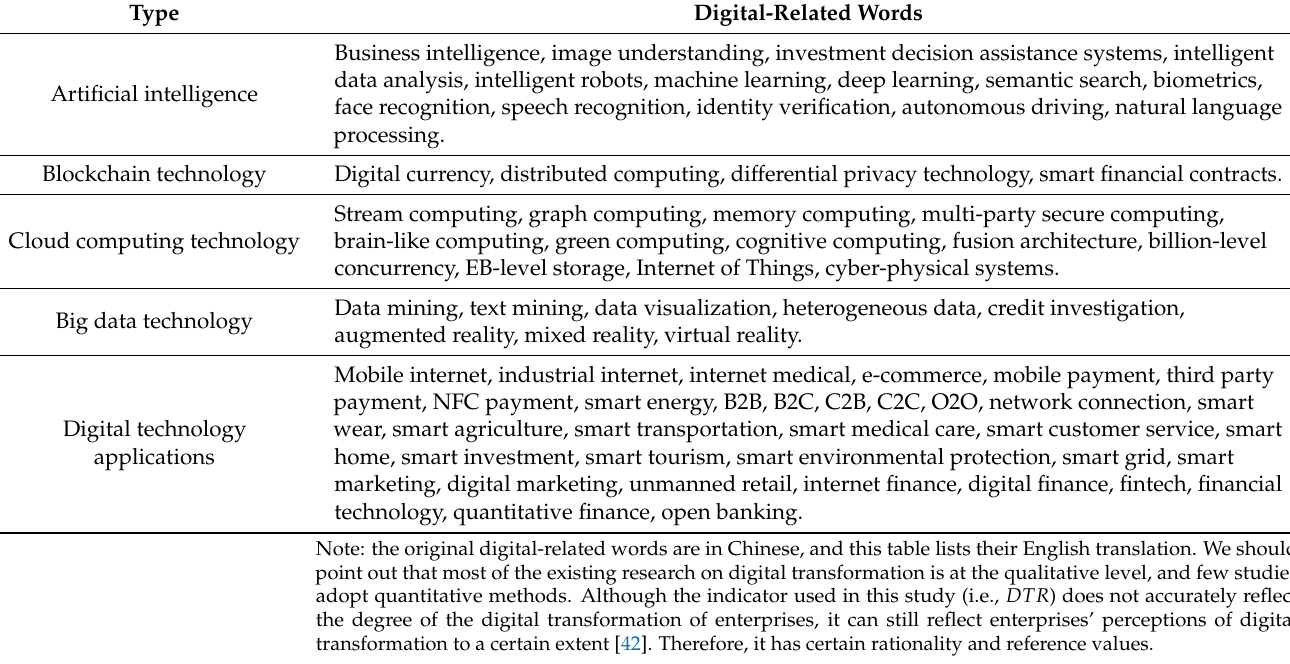
Table 6. Types of digitization categories and specific